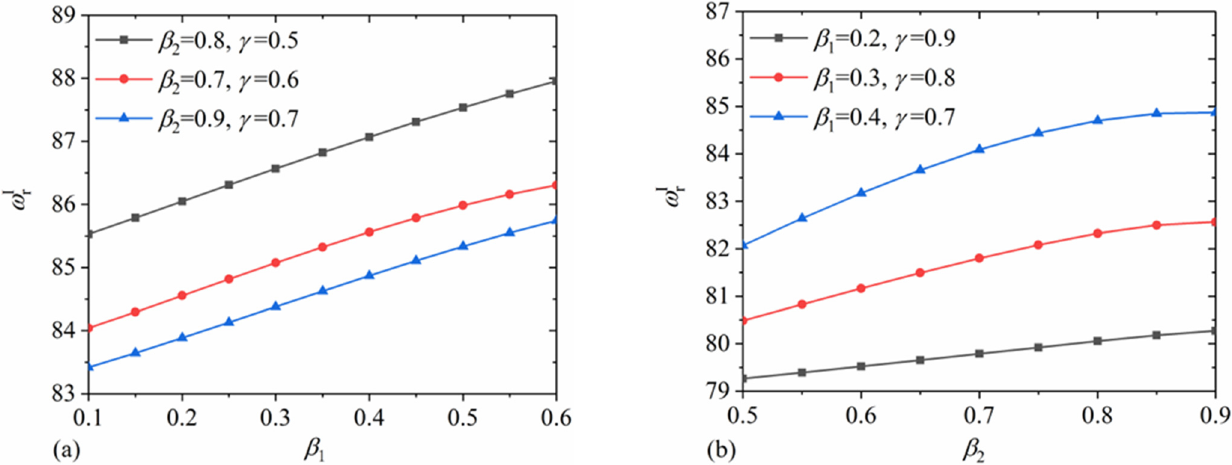
Figure 8. The rotational impulsive frequency for the baffle height: ( a ) the height of the lower baffle β 1 ; ( b ) the height of the upper baffle β 2 .